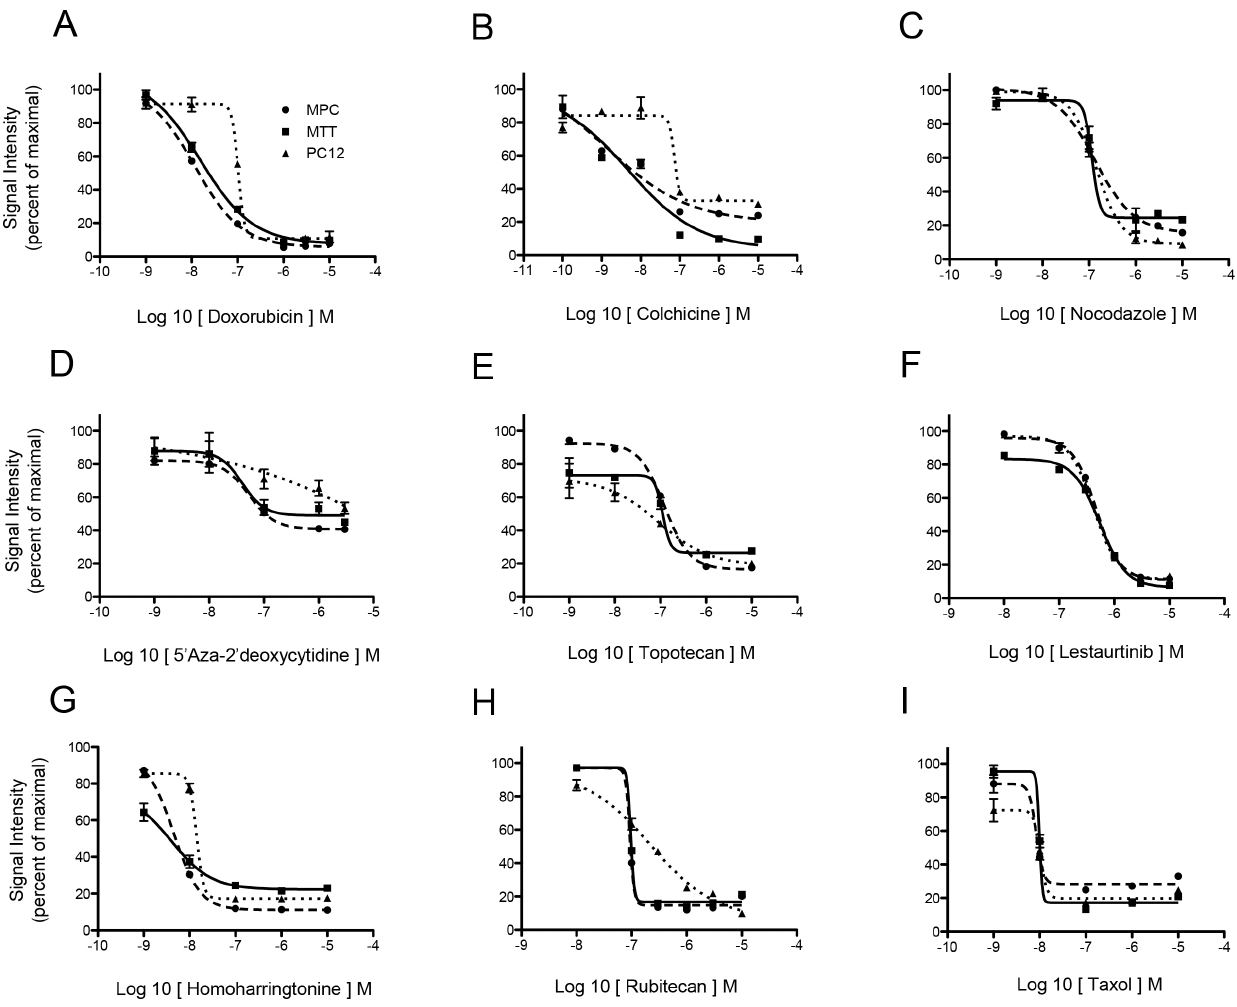
Figure 1. Validation of primary screening. Panel A and B: Dose response curves of the selected compound in MPC, MTT and PC12 PHEO cell lines. The Y-axis represents signal intensity as a percent of the maximal value. The X-axis represents the log 10 concentrations of the respective compound (inside square brackets).